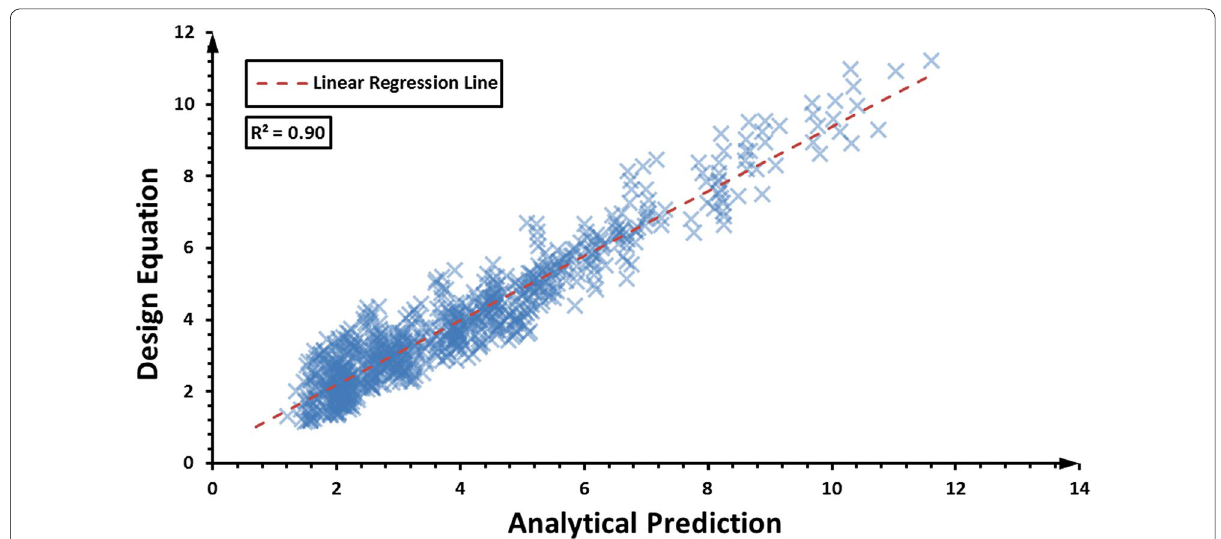
Fig. 12 Comparison of analytical and equation results for the energy-based